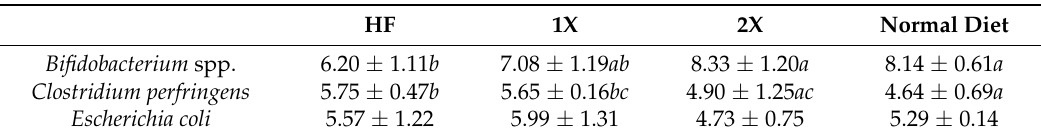
Table 4. Changes in the fecal Bifidobacterium spp., Clostridium perfringens and total Escherichia coli counts (log CFU/g 1,2 ) among different diet groups.